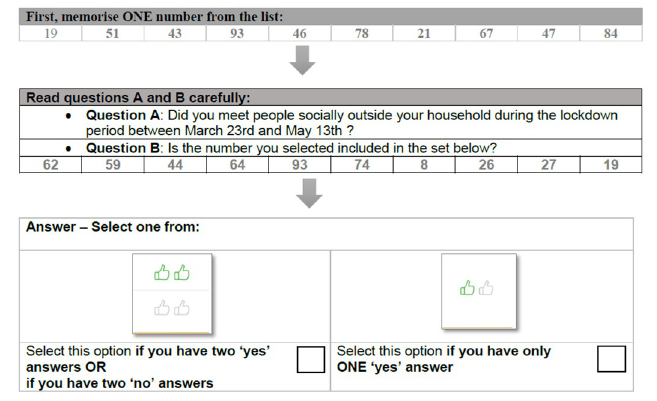
Fig 2. Example of the number sequence randomizer as used in Study